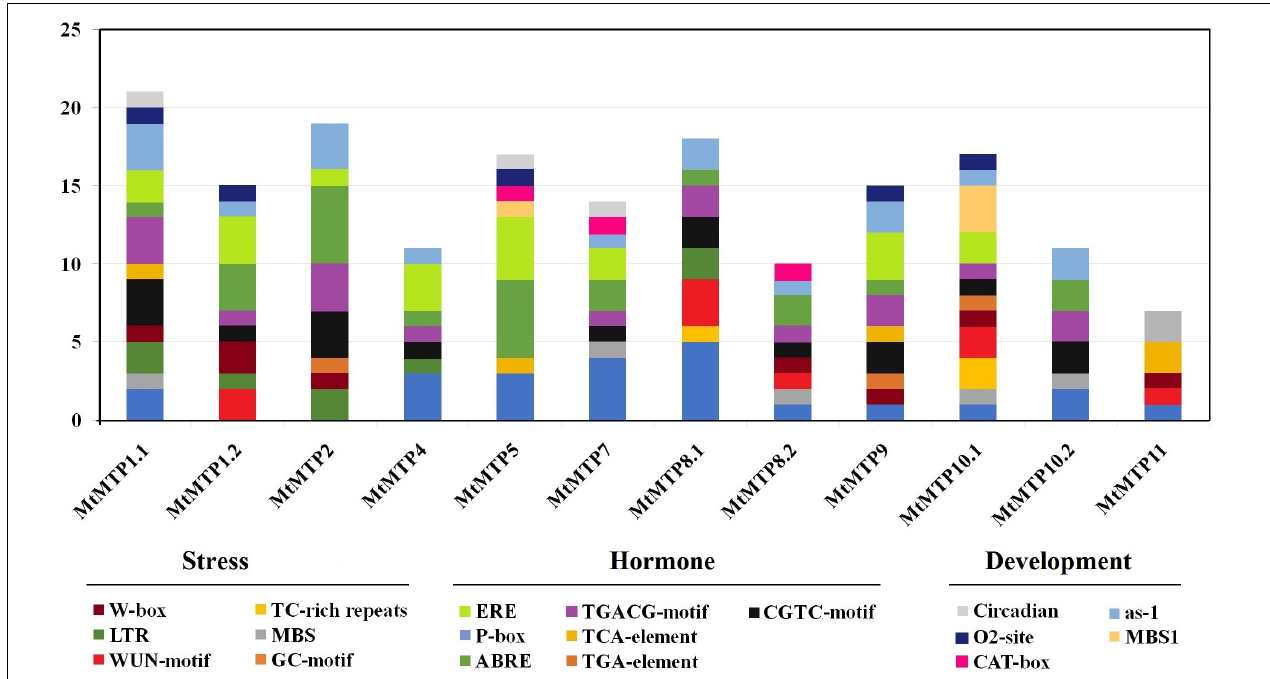
FIGURE 4 | Cis -regulatory elements in the promoter region of MtMTP genes. Cis -regulatory elements were identified in 2,000 bp promoter sequences upstream of the start codon of MtMTP genes using the online tools PlantCARE and PLACE. These elements are related to different functional diversity, represented by different